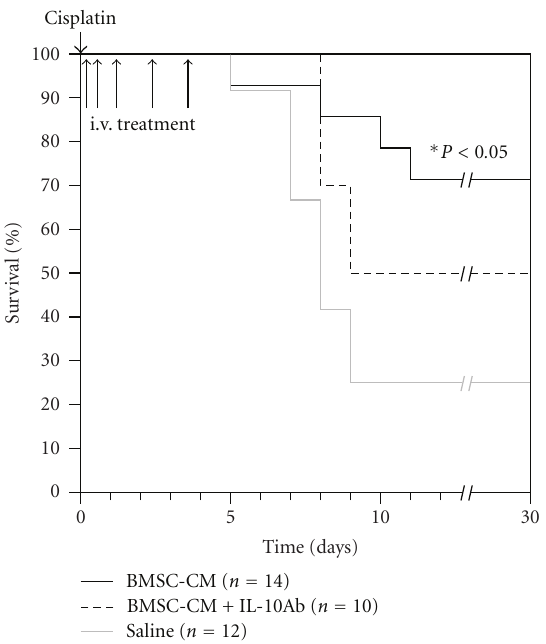
Figure 7: IL-10 antibody abates the survival benefit of BMSC- CM-administered to rats undergoing lethal cisplatin AKI . At hour 0, cisplatin dissolved in physiological saline (0.75mg/mL) was administered i.p. to male, SAS-SD rats at a lethal dose (7.5mg/kg). At hours 3, 9, 24, 48, and 72, 1 mL of either physiological saline ( n = 12), BMSC-conditioned medium ( n = 14) or BMSC-conditioned medium containing 4 μ g/mL neutralizing anti-rat IL-10 antibody ( n = 10) were administered i.v. to the cisplatin AKI rats. They were monitored for survival for 30 days. ∗ P < 0 . 05 for BMSC-CM compared to saline by Logrank